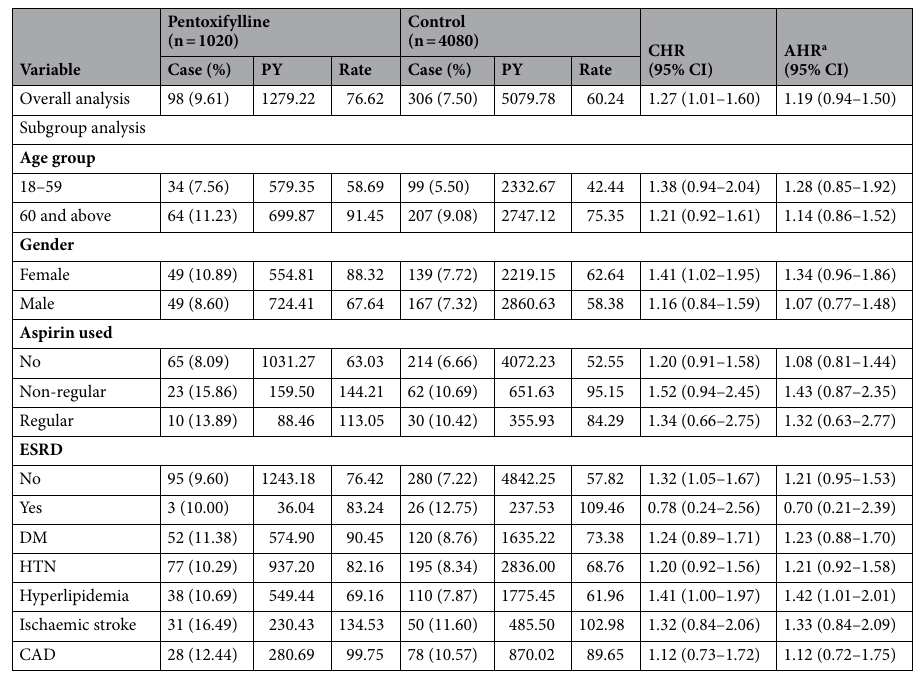
Table 2. The overall and subgroup analysis of haemorrhage or bleeding risk in patients with chronic kidney disease treated with and without pentoxifylline. AHR, adjusted hazard ratio; CAD, coronary artery disease; CHR, crude hazard ratio; DM, diabetes mellitus; ESRD, end-stage renal disease; HTN, hypertension. a Covariates adjusted by age groups, gender, group of aspirin used, DM, HTN, hyperlipidaemia, ischaemic stoke, ESRD, CKD stage 5 and dual antiplatelet therapy or anticoagulants . PY:1000 person